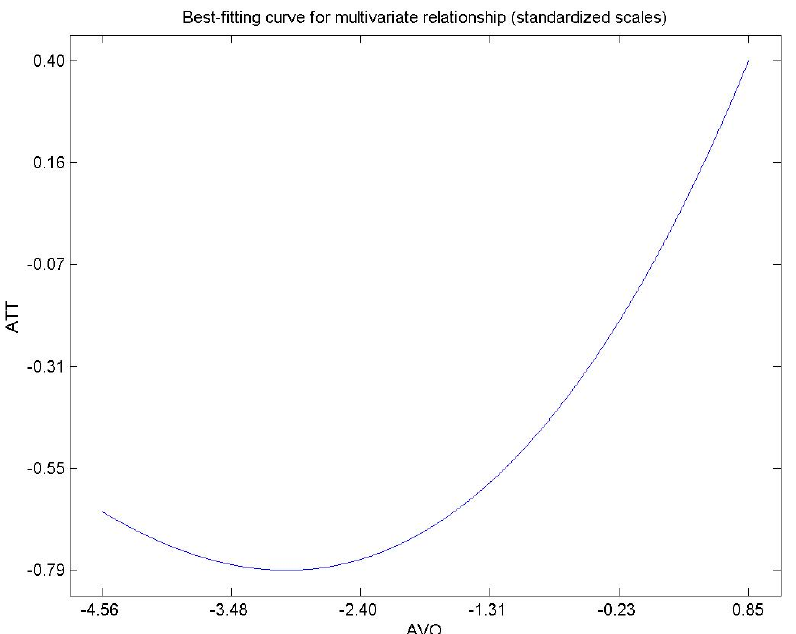
Figure 3. The non-linear relationship between altruistic values and attitudes towards minimalism.